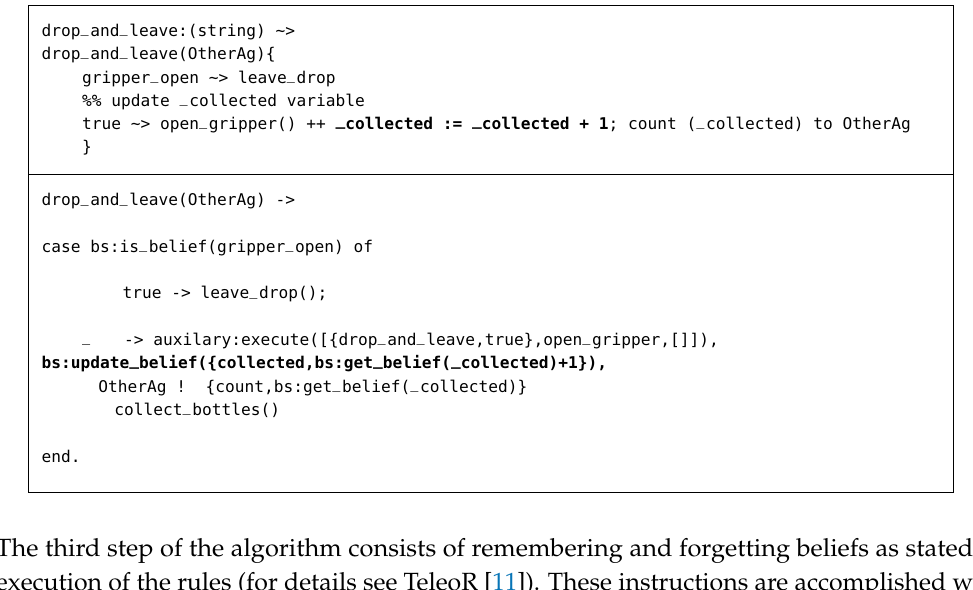
Table 9. TeleoR variable update (up). Erlang variable update